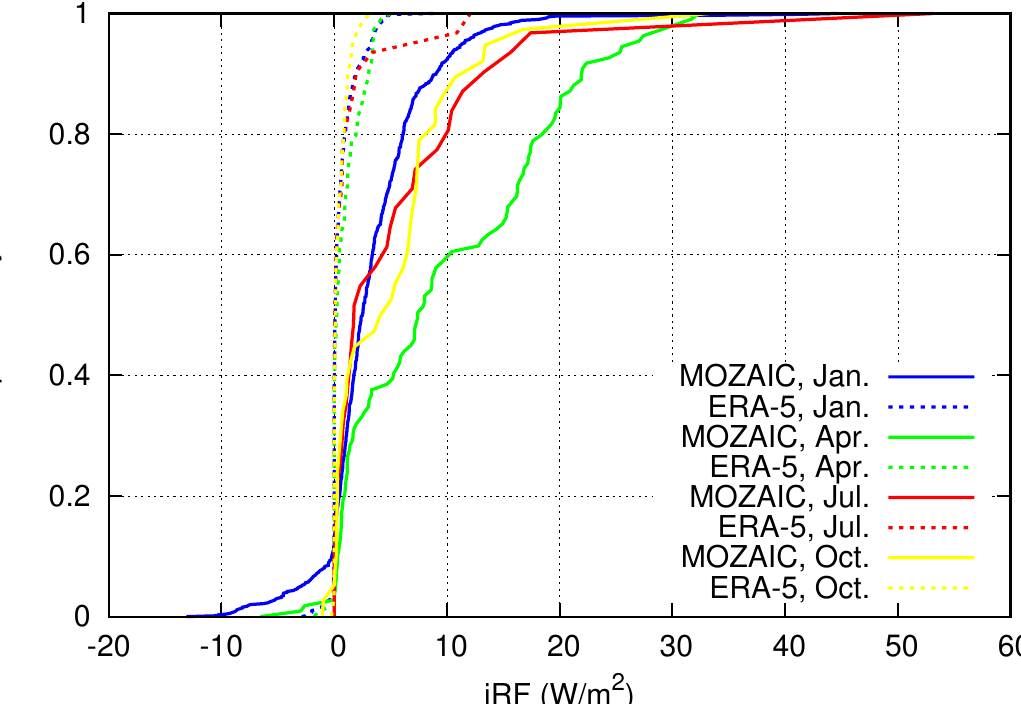
Figure 3. Cumulative probability distributions of instantanous radiative forcing of contrails for the four seasonal mid-months in 2014: January, April, July and October, both for MOZAIC data (solid lines) and the corresponding times and grid points in ERA-5 (dashed).